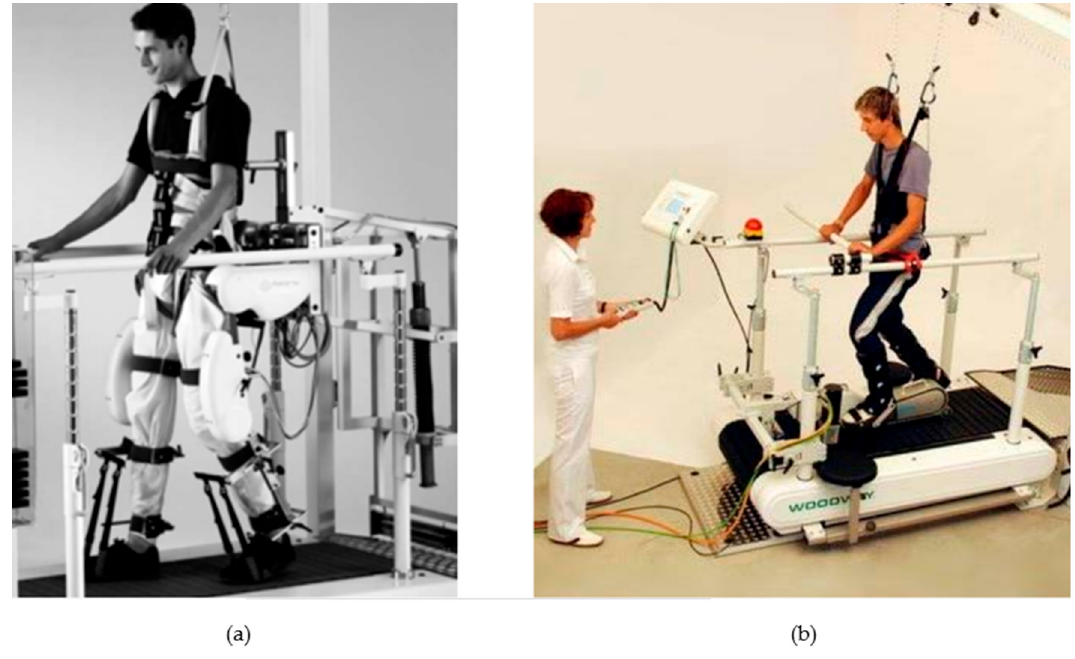
Figure 6. Rehabilitation equipment. ( a ) LOKOMAT; ( b ) LokoHelp. ( Figure 6 was reproduced with permission from [75].)